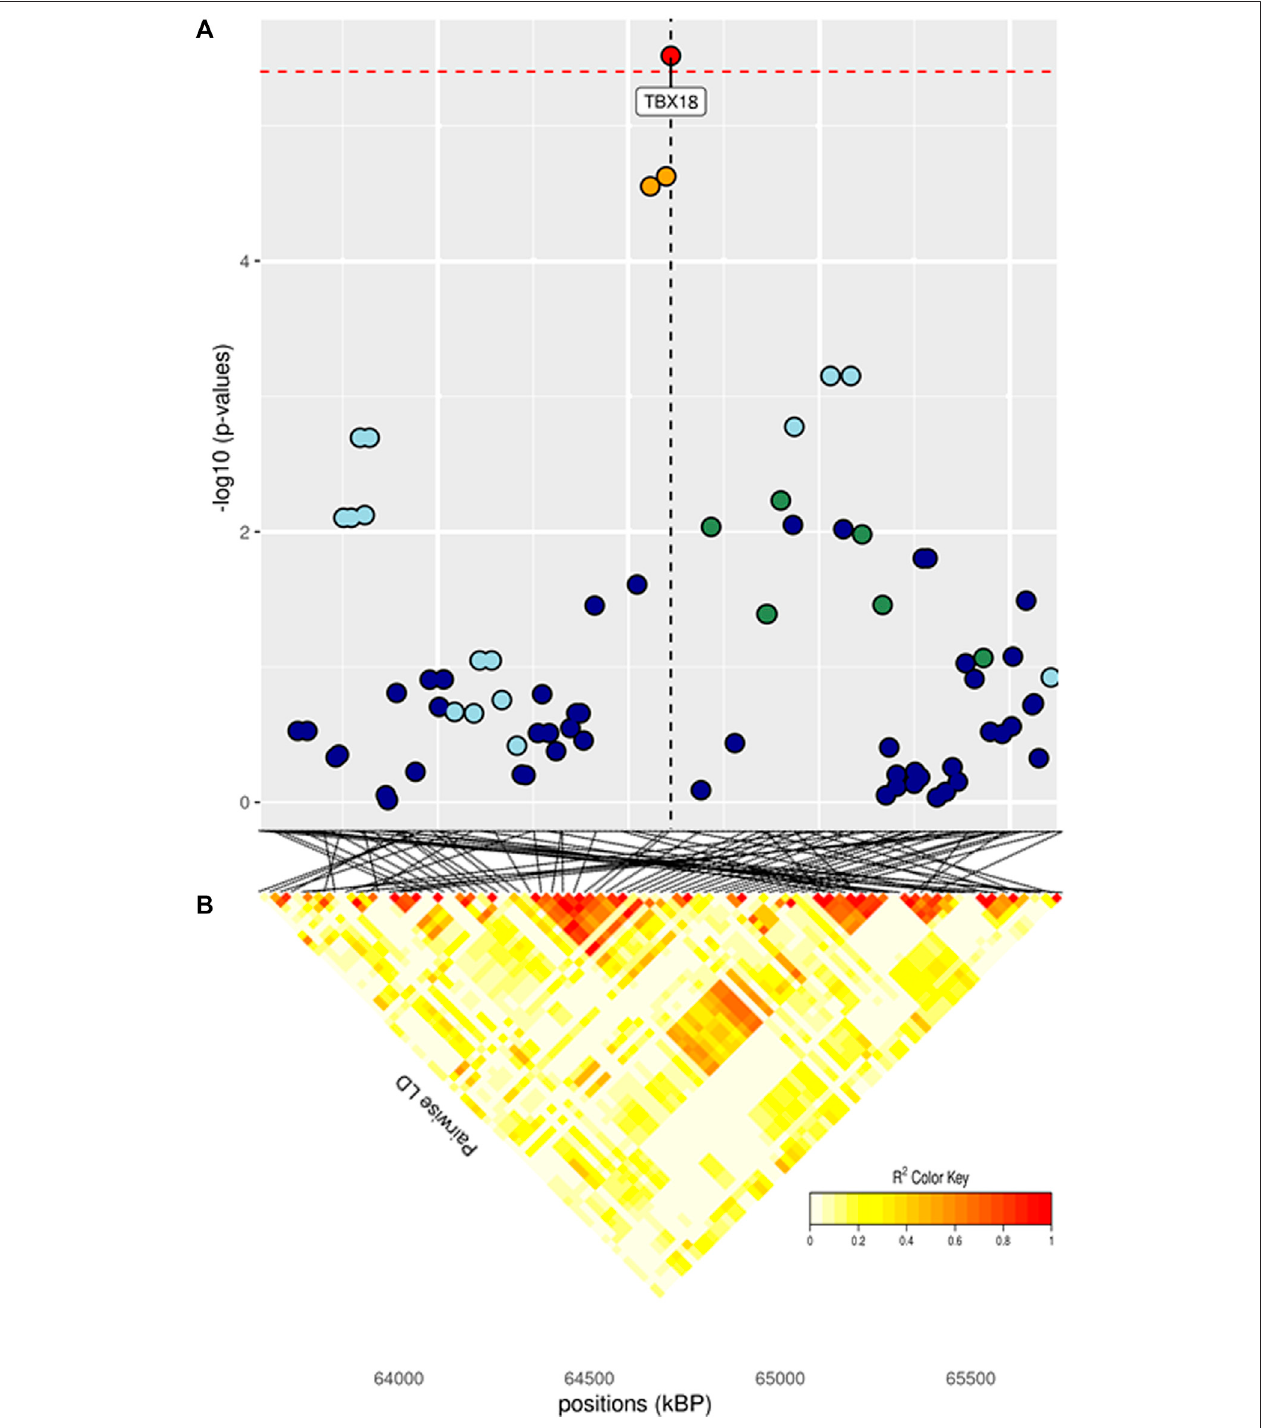
FIGURE 3 | (A) Localized linkage disequilibrium analysis of BW_i. Manhattan plots displaying the level of signi fi cance (y-axis) over genomic positions (x-axis) in a window of 0.5 Mb upstream and downstream of the most signi fi cantly SNP. Vertical line represents the position of candidate gene TBX18 . Different colors are used to represent the pairwise LD with the closest signi fi cant SNPs: blue < 0.2; light blue < 0.4; green < 0.6; yellow < 0.8 and red > 0.8. (B) Represents linkage disequilibrium of that area.